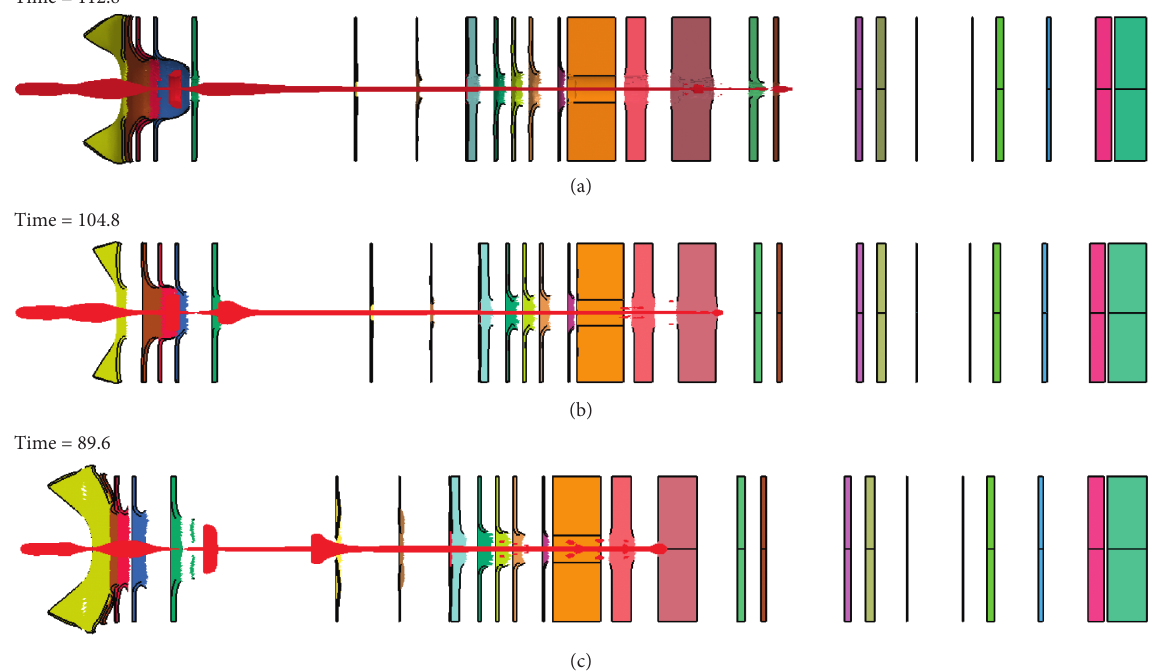
Figure 11: The time and position of jet fracture: (a) the liner is copper; (b) the liner is steel; (c) the liner is aluminum.